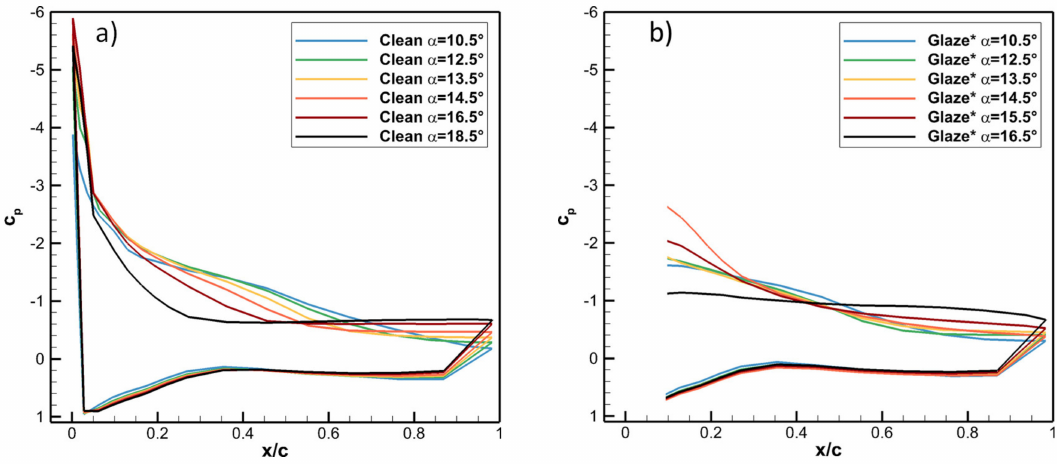
Figure 12. Pressure coe ffi cient distribution for the clean ( a ) airfoil and the glaze* ice shape ( b